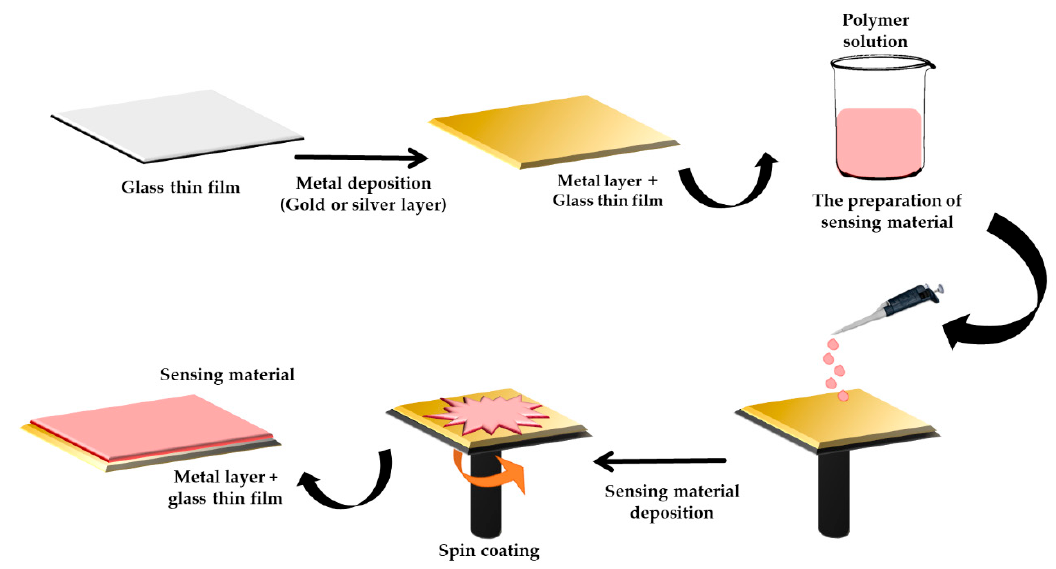
Figure 6. Schematic of the fabrication process of a thin film for surface plasmon resonance [12].